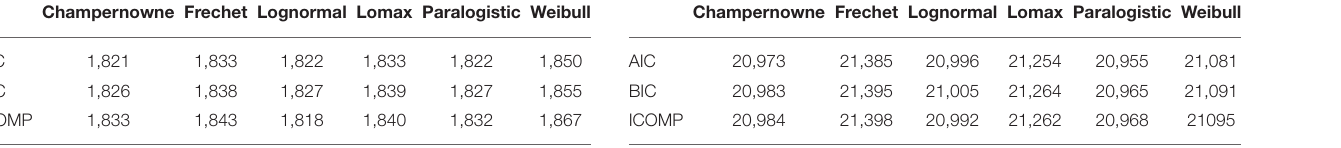
TABLE 10 | Simulation: Information criteria for Champernowne, Frechet, Lognormal, Lomax, Paralogistic, and Weibull models. Champernowne Frechet Lognormal Lomax Paralogistic